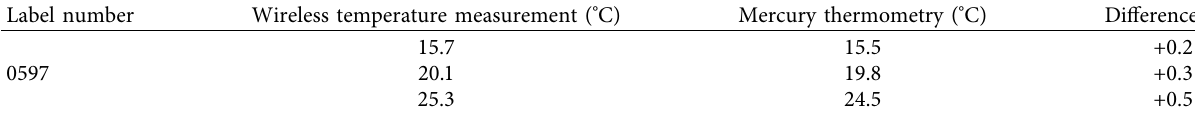
Table 4: Comparison of temperature labels and mercury thermometers.